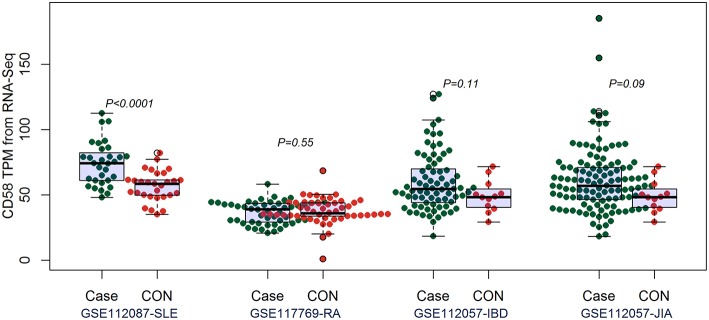
Validation of the expression of CD58 in SLE, RA, IBD, and JIA patients. The transcripts per million (TPM) value of CD58 were calculated from the raw read counts of four RNA-seq datasets including SLE (GSE112087), RA (GSE117769), IBD (GSE112057IBD), and JIA (GSE112057JIA), respectively. Difference between groups was analyzed using unpaired t-test. CD58 was aberrantly expressed between SLE patients and controls (P < 0.0001), but it not obvious in RA (P = 0.55), IBD (P = 0.11), and JIA (P = 0.09).